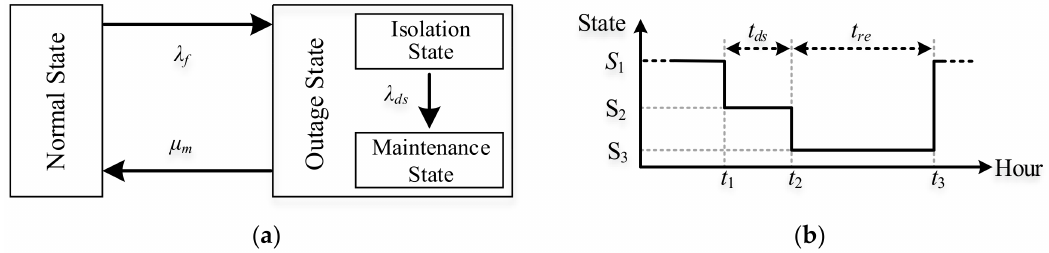
Figure 2. ( a ) Three-state reliability model. ( b ) Time series of state